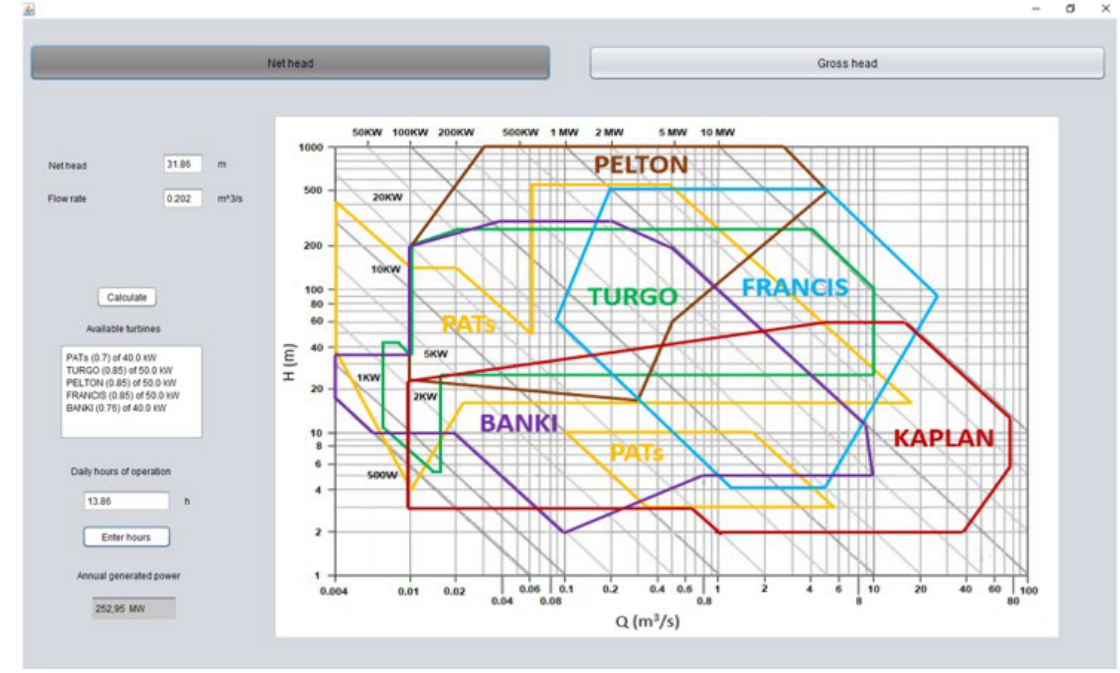
Figure 3. Main window of the computer application developed: results of case study 1. Water 2021 , 13 , x FOR PEER REVIEW